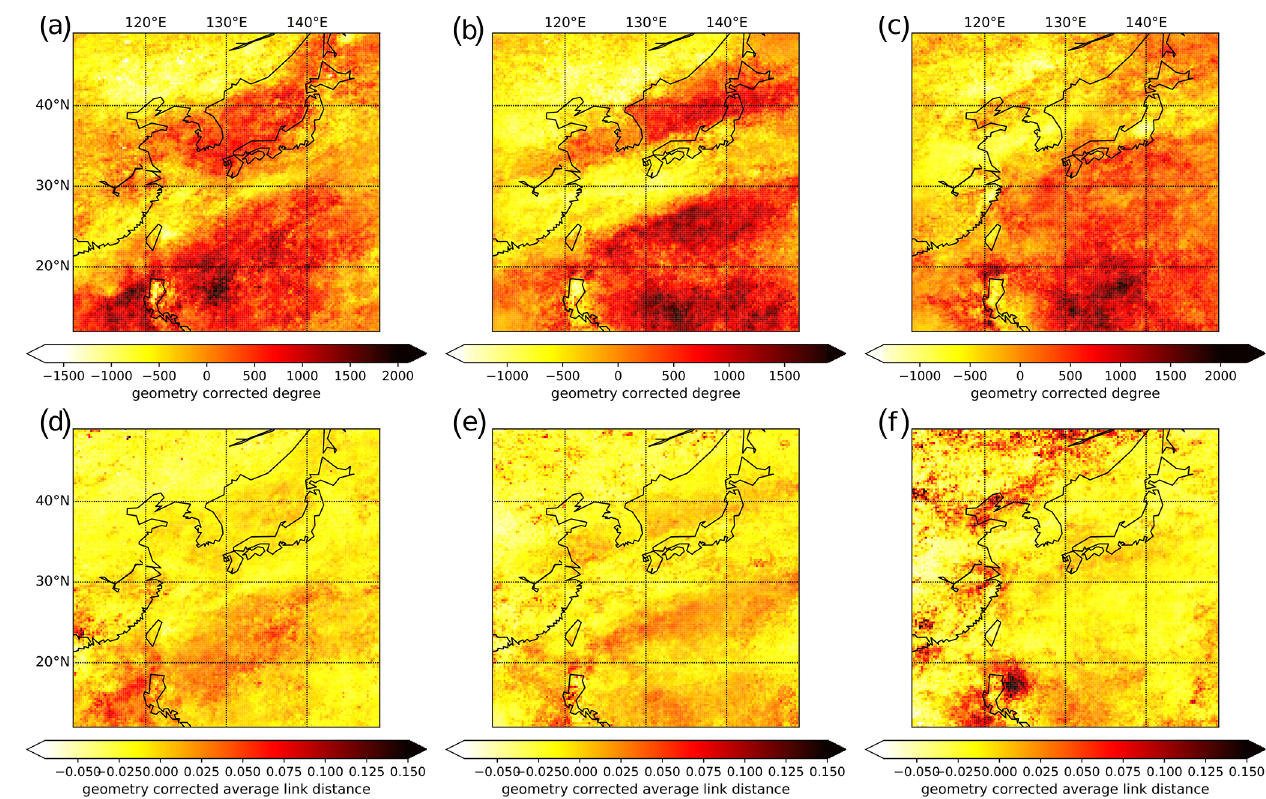
Figure 3. Network evolution during the active Baiu phase from May to July (left to right). Panels (a–c) show the degree patterns of the monthly networks, while panels (d–f) show the respective average link distance